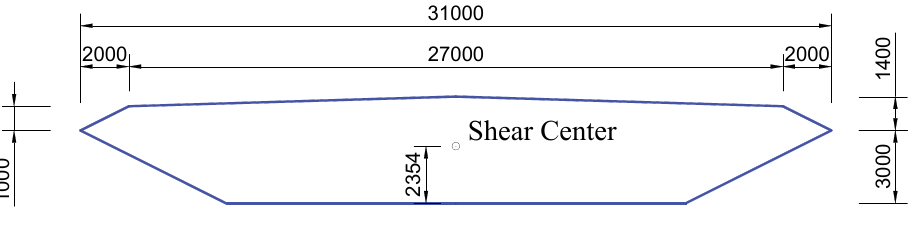
Figure 2. Girder cross-section of GBEB main span (unit: mm).